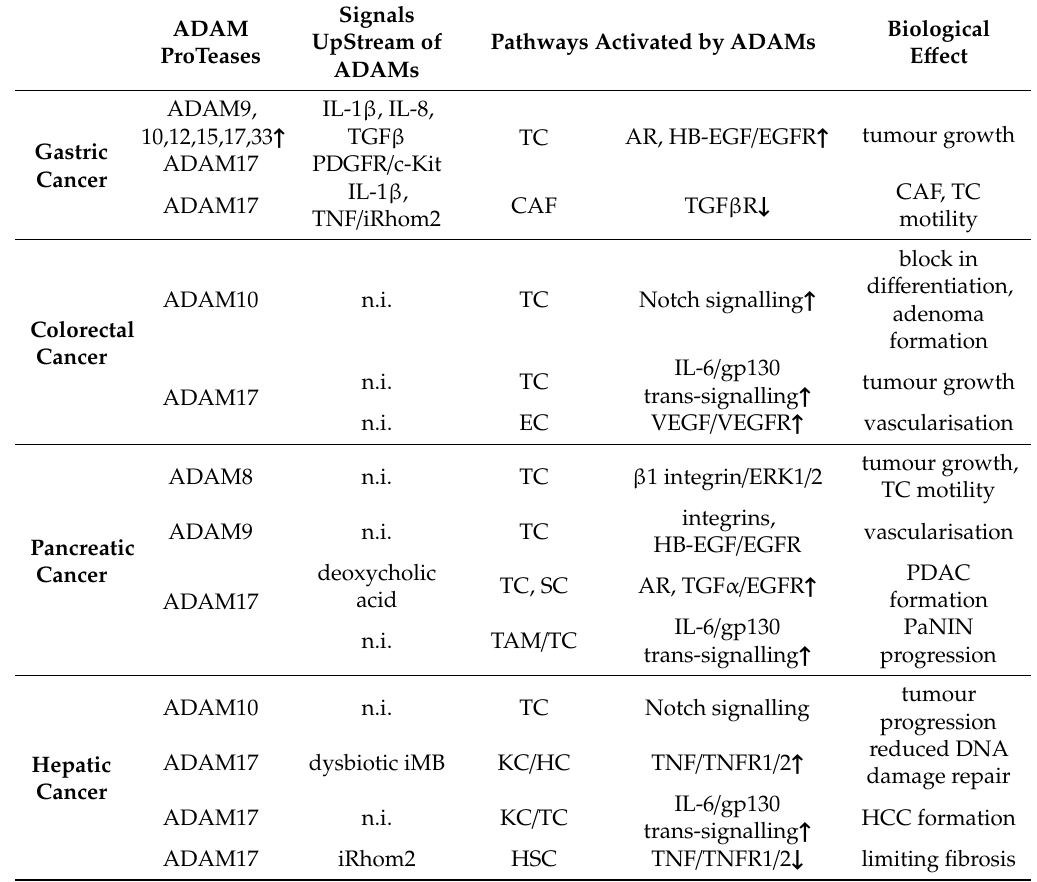
Table 2. Overview of ADAM protease activity in gastroenterological